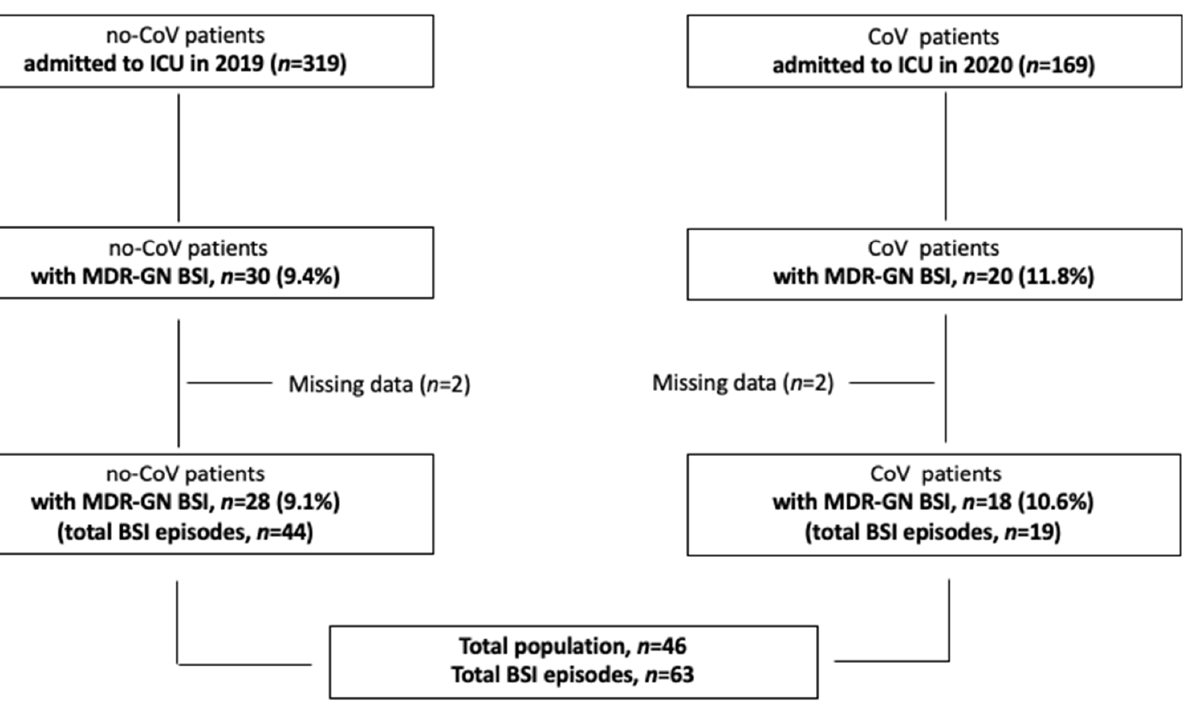
Figure 2. Flow chart of the study population. Abbreviations : no-CoV: pre-COVID-19 pandemic period; CoV: during COVID-19 pandemic; ICU: intensive care unit; MDR-GN: multi-drug-resistant Gram-negative bacteria; BSI: bloodstream infection.